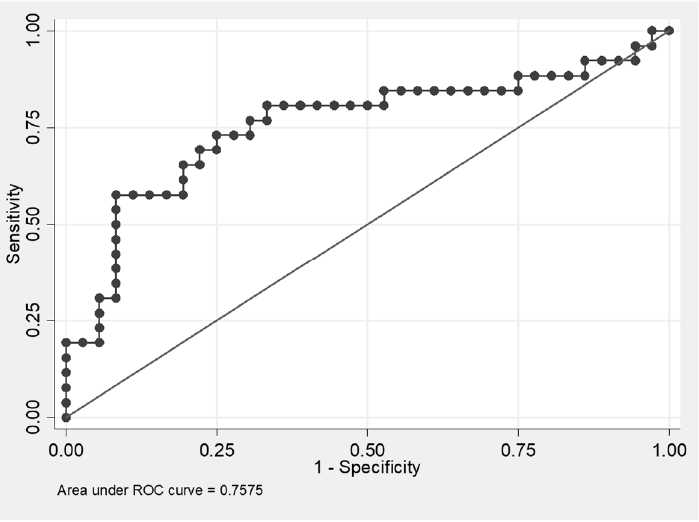
Figure 6. ROC curve of CX3CL1/ADAM17 predictive ability to discriminate IPF (idiopathic pulmonary fibrosis from OFI (other fibrosis than IPF). Youden’s index = 0.4936; the cut off value of CX3CL1/ADAM17 ratio associated with the highest value of Youden’s index is CX3CL1/ ADAM17 =99.092; sensitivity = 0.5769; specificity = 0.9167.